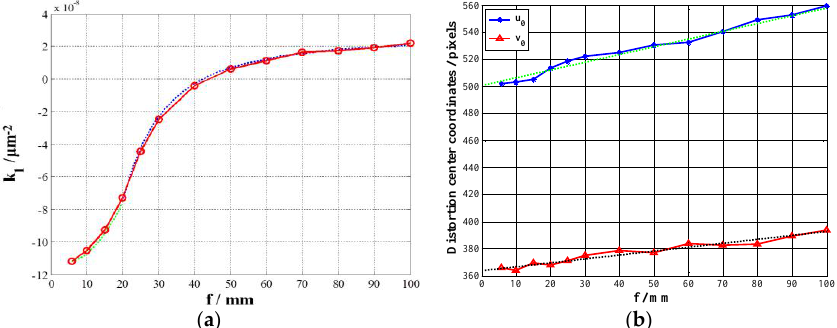
shown in Figure 11b.